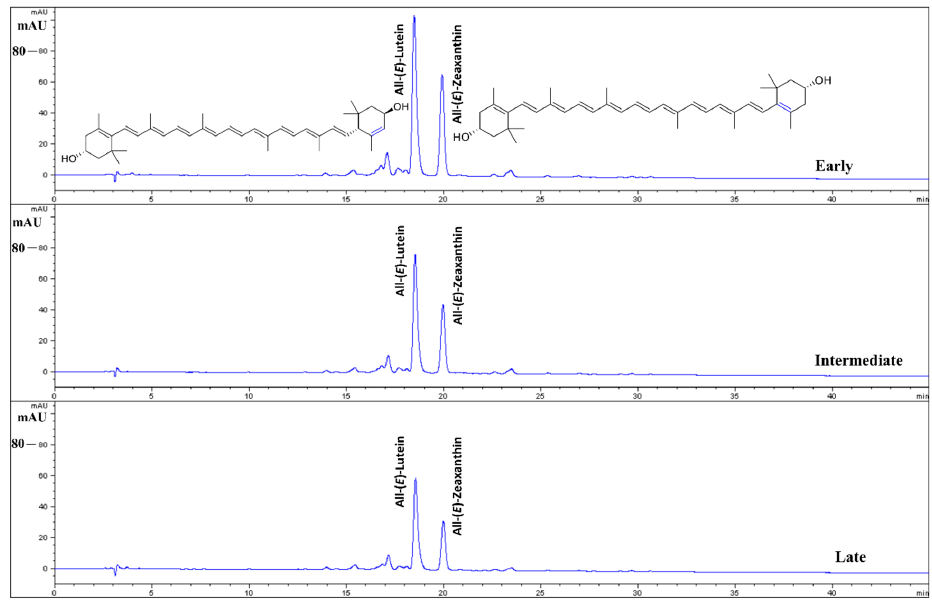
Figure 3. High-performance liquid chromatography (HPLC)-diode-array detection (DAD) chromatograms (450 nm) showing the dominance of (all- E )-lutein (RT—18.517 min) and (all- E )-zeaxanthin (RT—19.955 min) in the egg yolks of eggs obtained from early, intermediate, and late-age laying hens. All the chromatograms are on the same scale. RT: retention time.